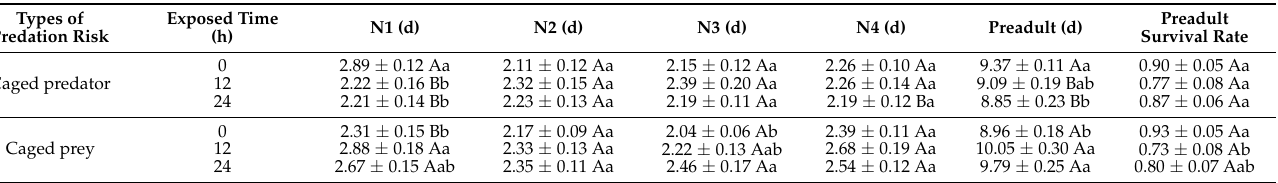
Table 2. The effects of the predation risks on the developmental duration (N1 to adult) and preadult survival rate of Sitobion miscanthi . Values are presented by the mean ±